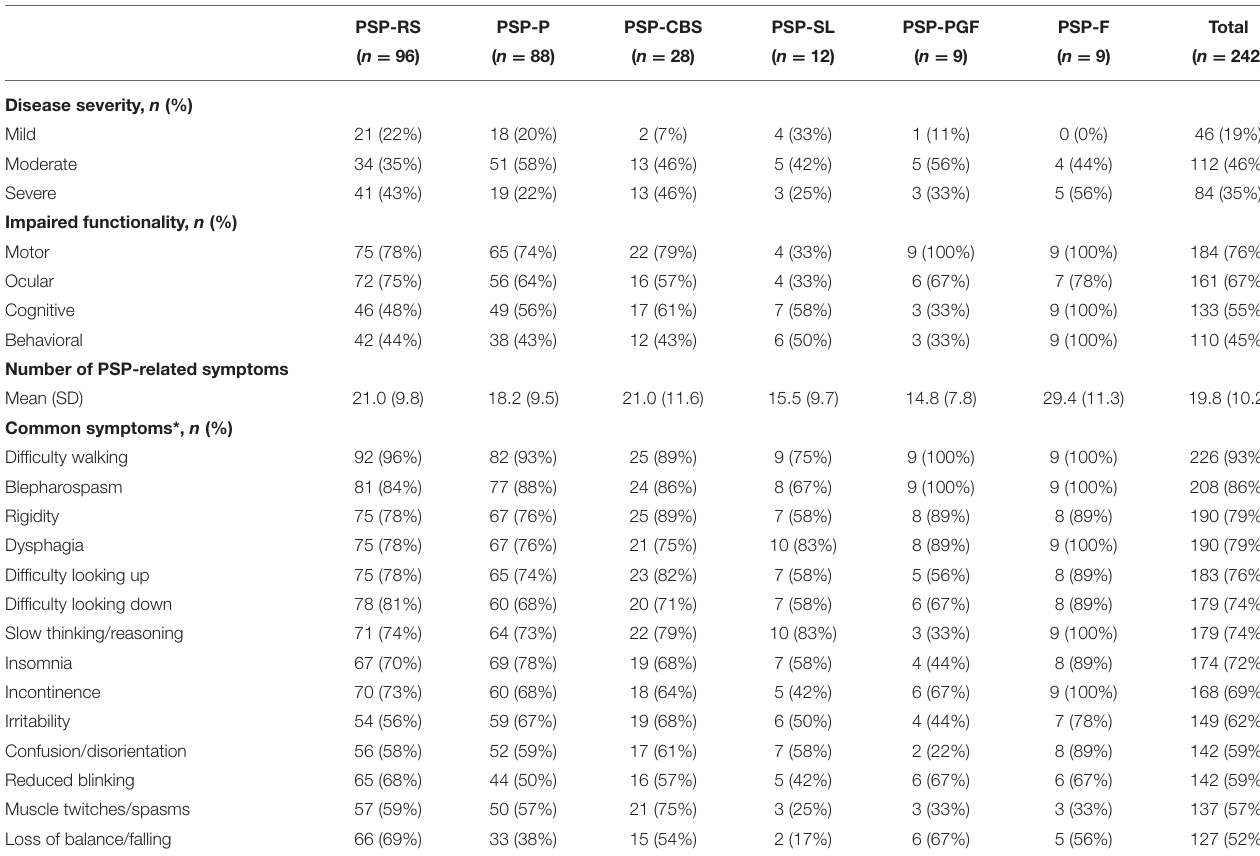
TABLE 2 | Patient burden (disease severity, functional impairment, and symptom presentation), by PSP